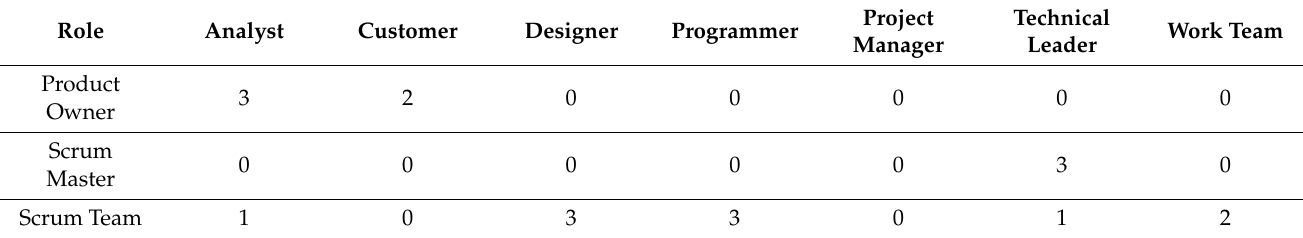
Table 4. Compliance analysis of roles in ISO/IEC29110 and Scrum methodologies.